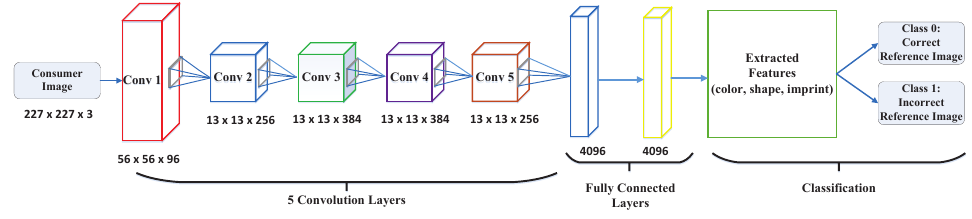
Figure 6. An overview of the proposed CNN model